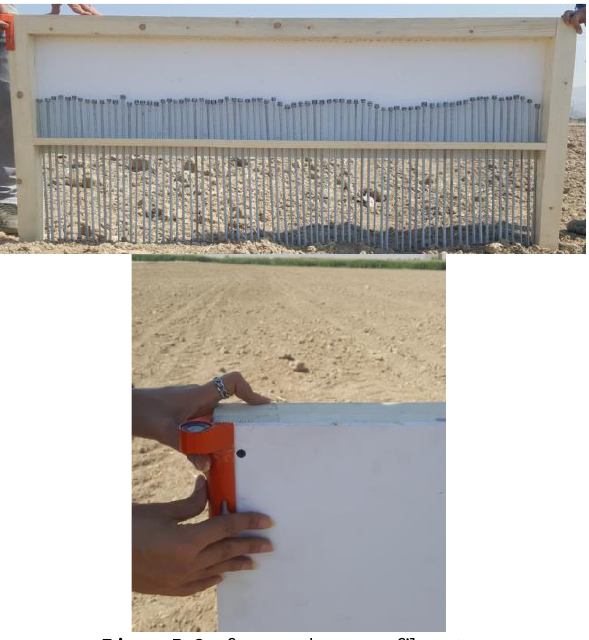
Figure 5. Surface roughness